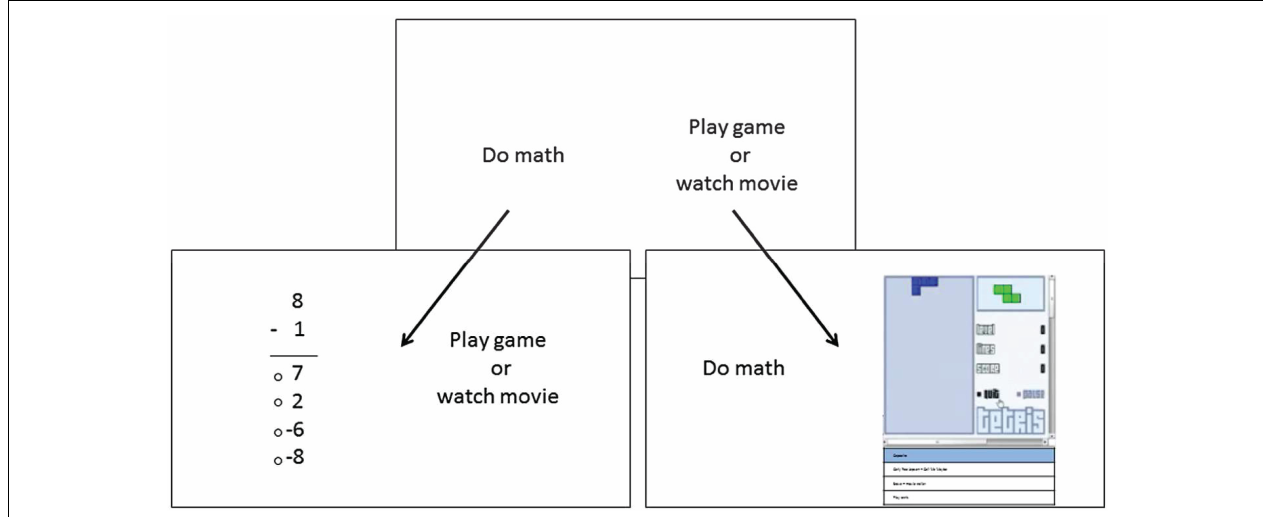
FIGURE 3 | Graphical interface of the Academic Diligence Task (Galla et al., 2014). Participants toggle between solving math problems vs. playing Tetris or watching entertaining videos.